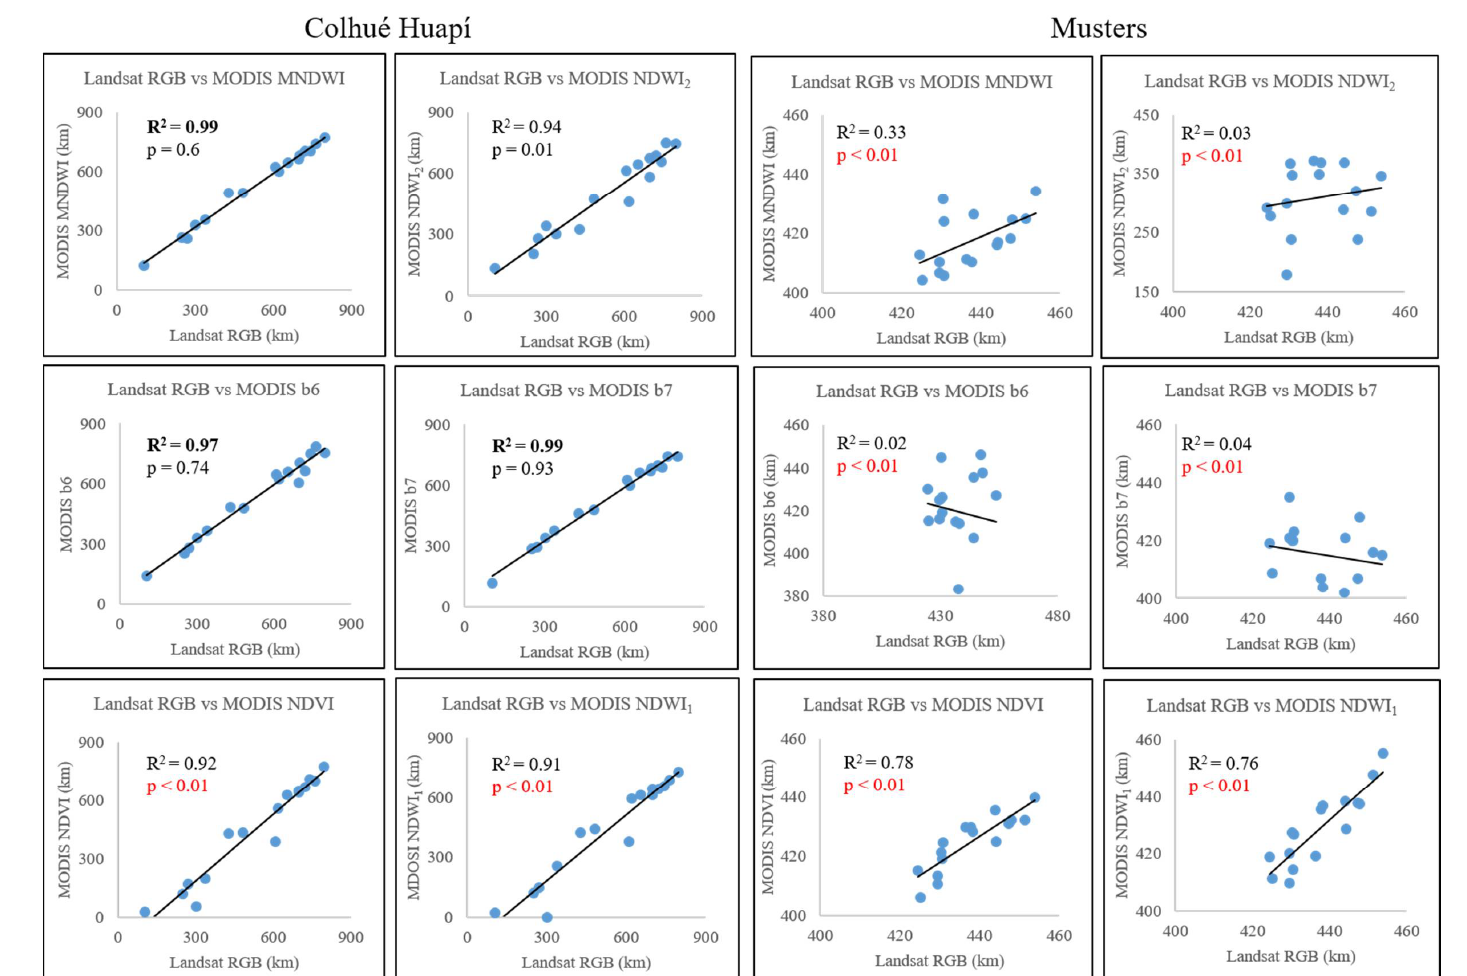
Figure 4. Scatter plots between the time series of the MU and CH lakes area obtained from Landsat images, and the MODIS bands and indexes. Marked differences are significant at p < 0.01 (Red), while correlations are significant at R 2 > 0.95 (Bold).